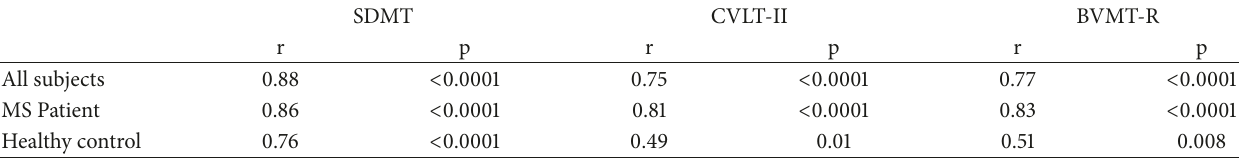
Table 4: Test-retest reliability.